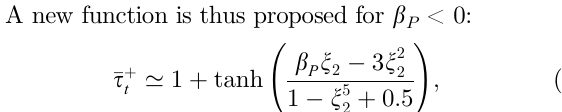
Figure 3. Mean velocity pro fi les under zero-pressure gradient conditions: comparison between experimental data from Öster- lund [28] (circles) and model (solid line) at Re + = 9.7 (cid:3) 10 2 (green), Re + = 2.1 (cid:3) 10 3 (blue) and Re + = 4.8 (cid:3) 10 3 (black).